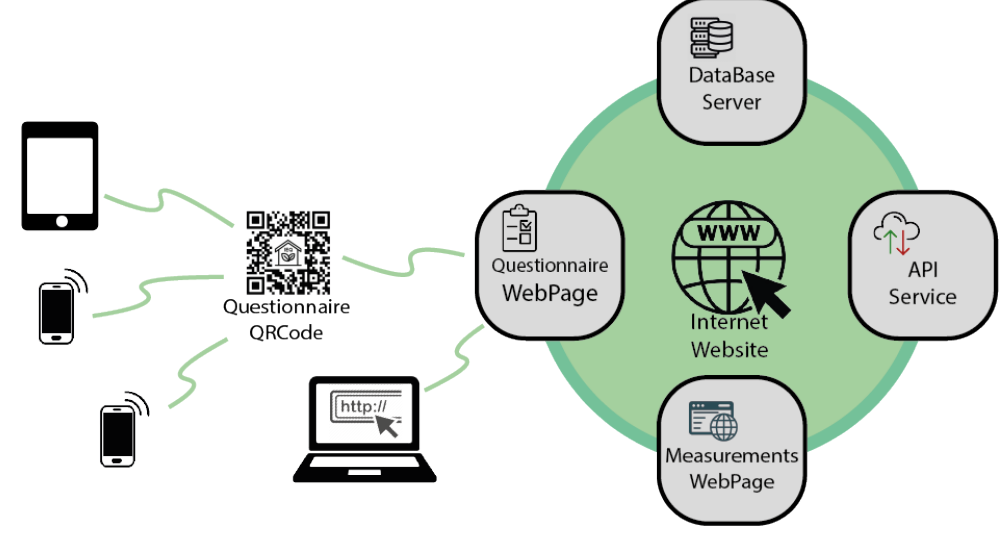
Figure 5. Website